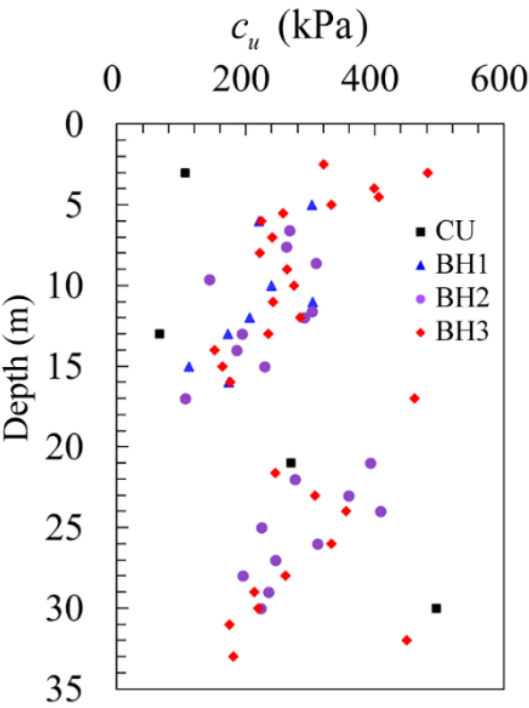
Figure 6. Undrained shear strength.